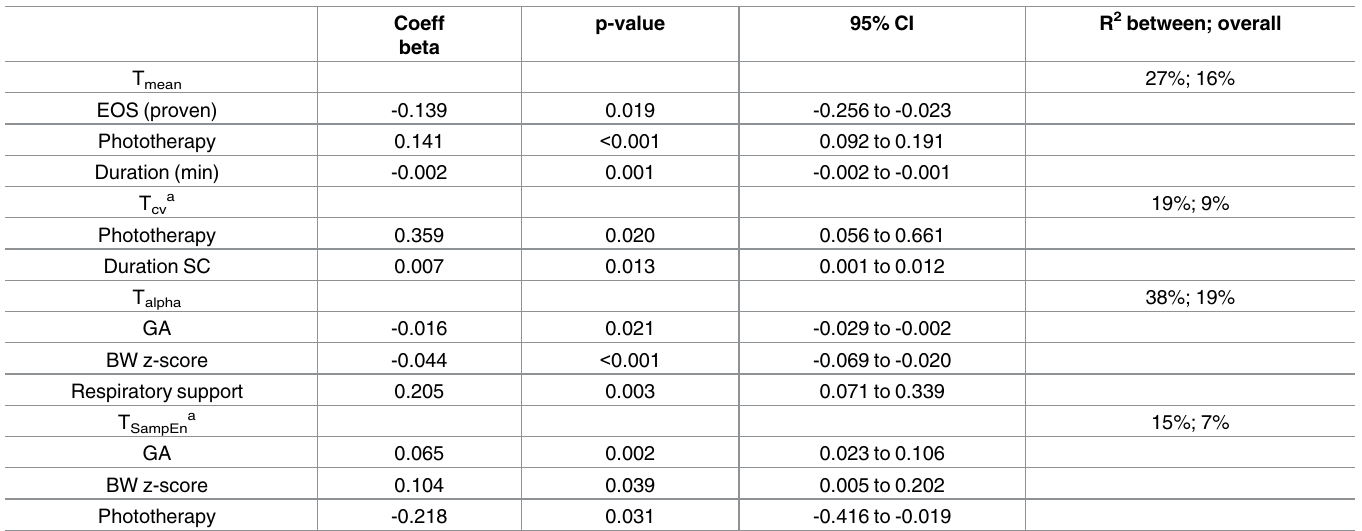
Table 4. Multivariable, multilevel linear regression analysesof all